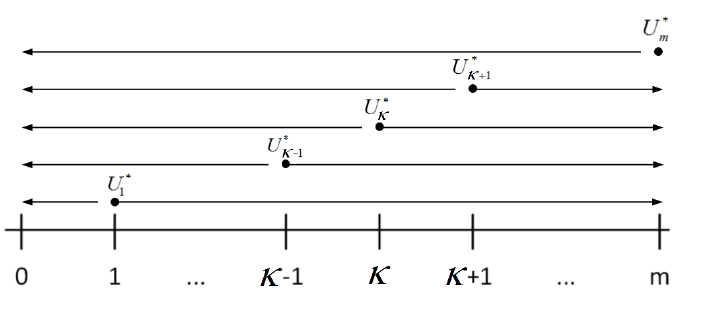
Figure 2. Building blocks of new